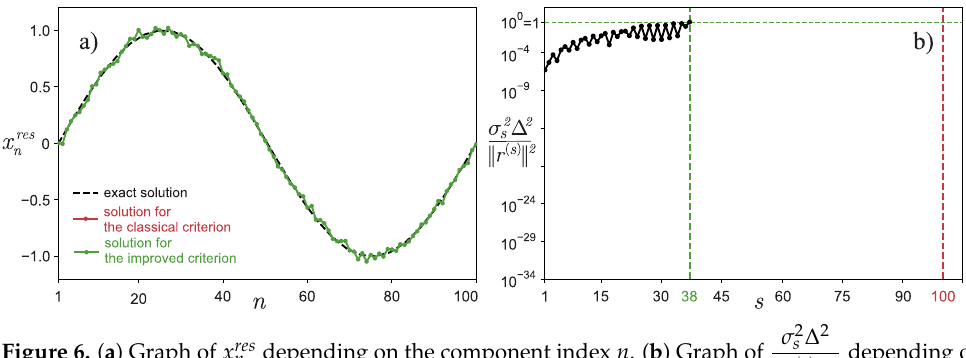
σ 2 s ∆ 2 depending on (cid:107) r ( s ) (cid:107) 2